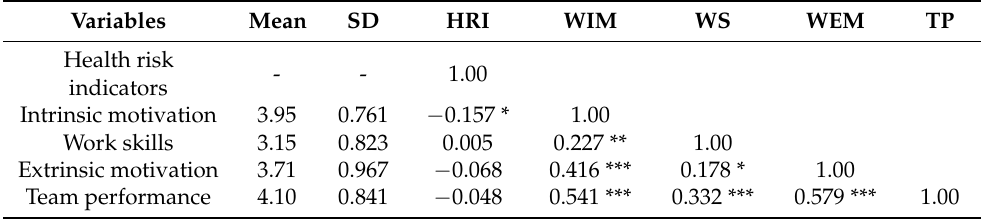
Table 5. Correlation matrix and descriptive statistics for the older workers’ group (Group